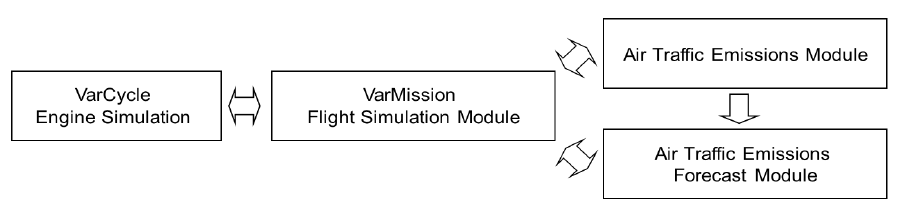
Figure 1. Schematic of model